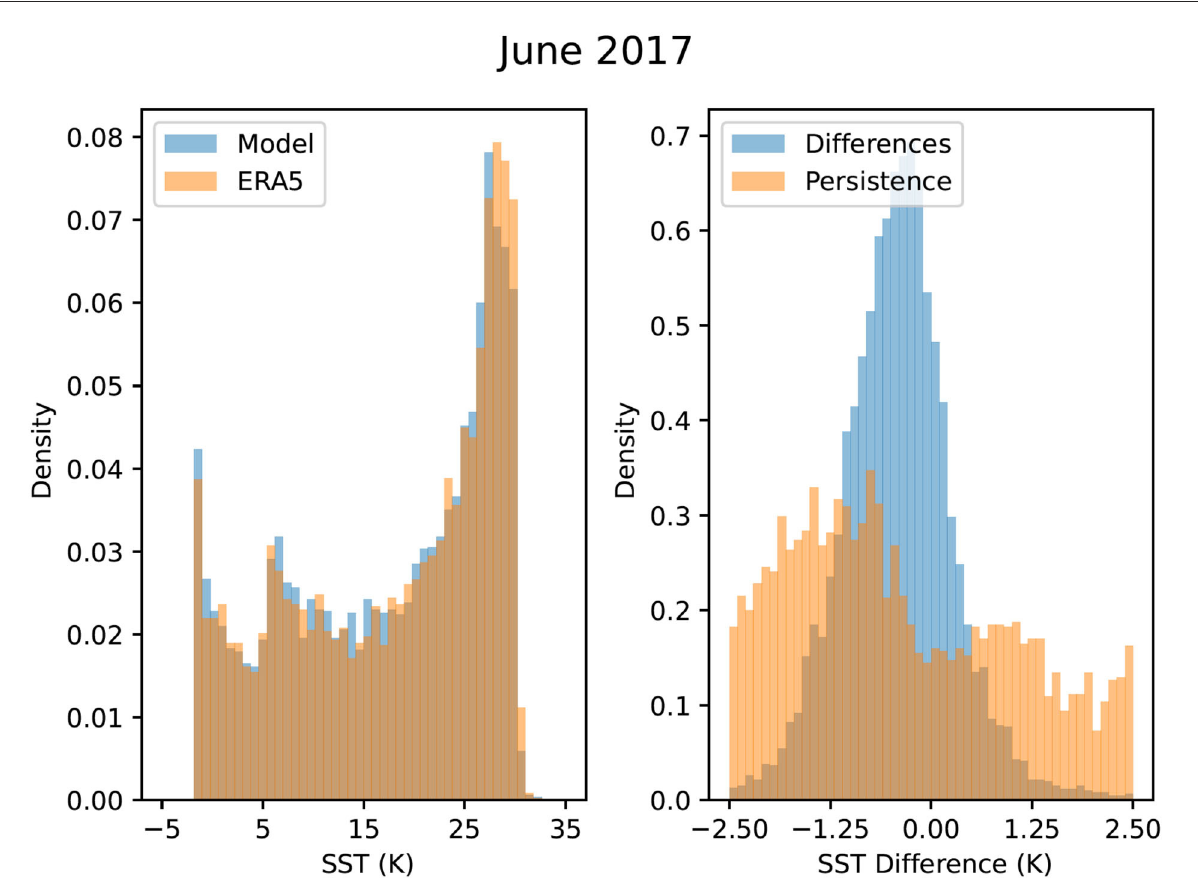
FIGURE8 Histograms of the model predicted SST values in comparison with the ERA5 SST values for June 2017 at the end of the 18-month prediction period. The second panel shows a histogram of the differences between the model and the ERA5 SST values in comparison with errors produced by assuming